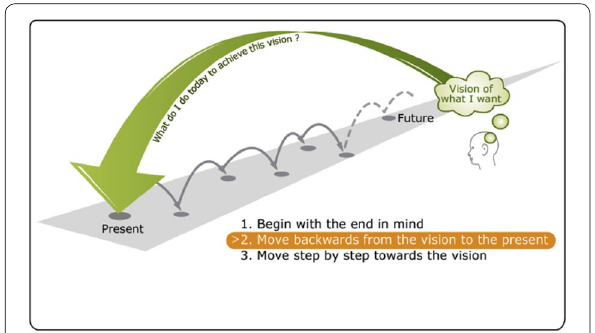
Fig. 1 The backcasting process from the Natural Step (source: Holmberg